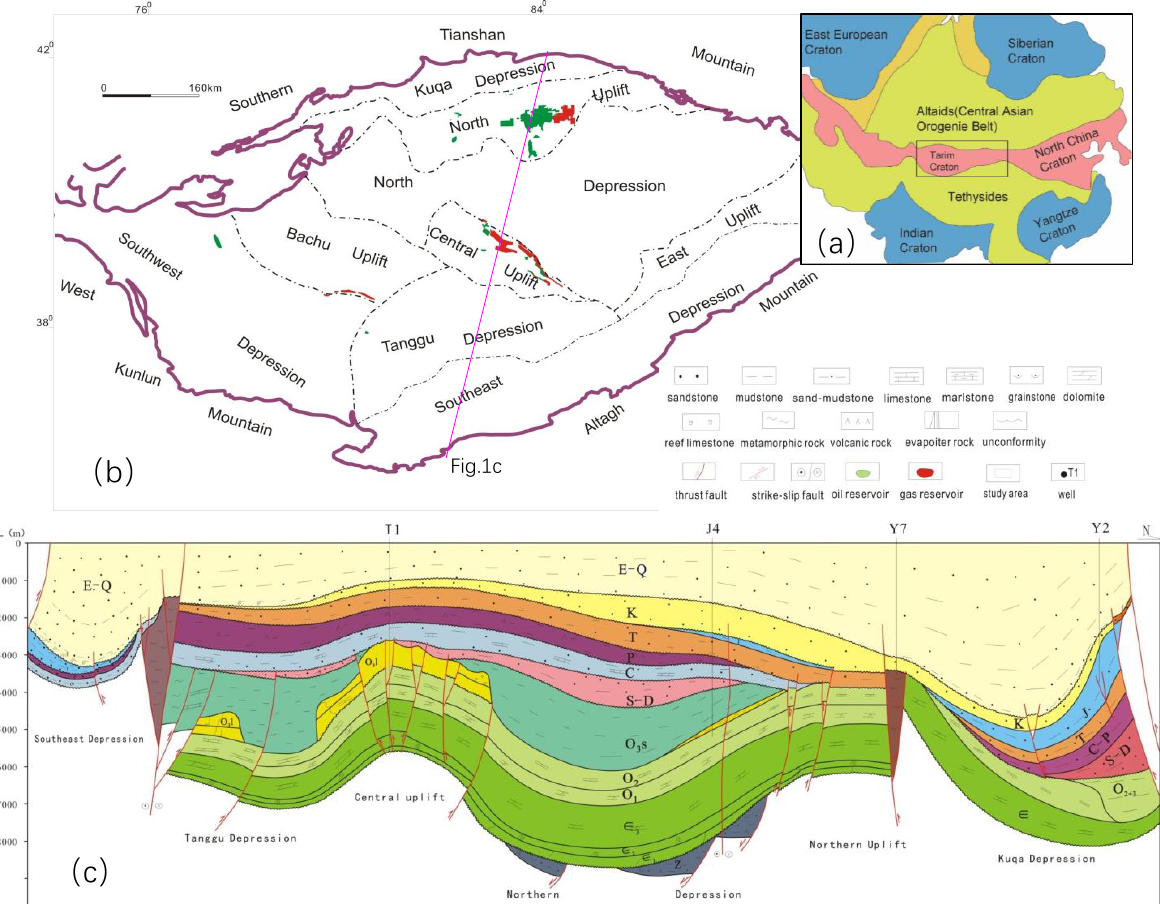
Figure 1. ( a ) The tectonic location of the Tarim Craton, ( b ) the tectonic unit division and the oil/gas accumulation in the Cambrian – Ordovician carbonates, and ( c ) geological section across the Tarim Basin (revised after reference [22]).